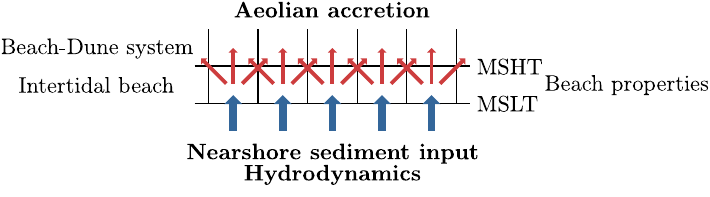
Figure 1. Conceptual model for Aeolian (red arrows) and Hydrodynamics (blue arrows) accretion sand exchange across a